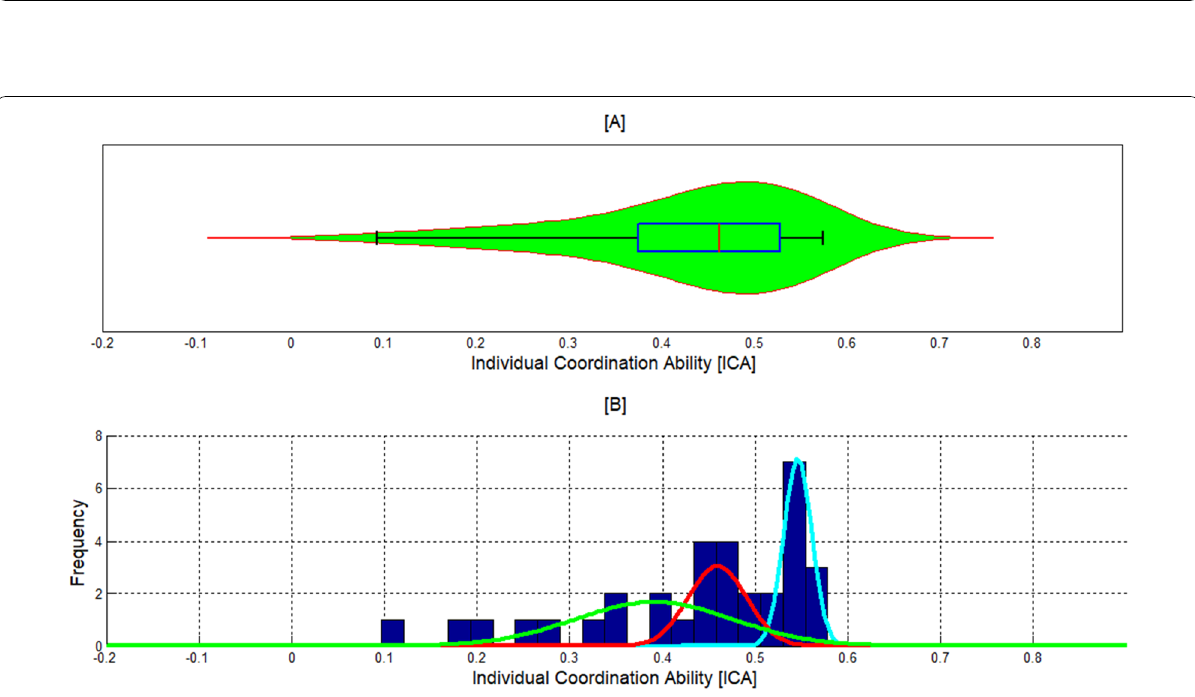
Fig. 6 ICA score distribution of the validation group. A Violin plot with boxplot. B Histogram with Gaussian mixture model